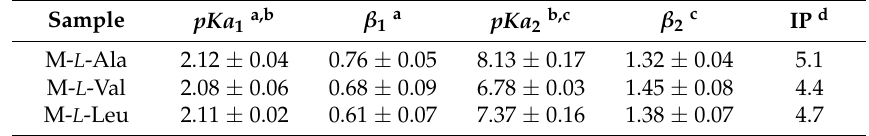
Table 1. pK a and β values of PAACs in the α range 0.2–0.8 ( β 1 ) and 0.1 − 0.9 ( β 2 ).